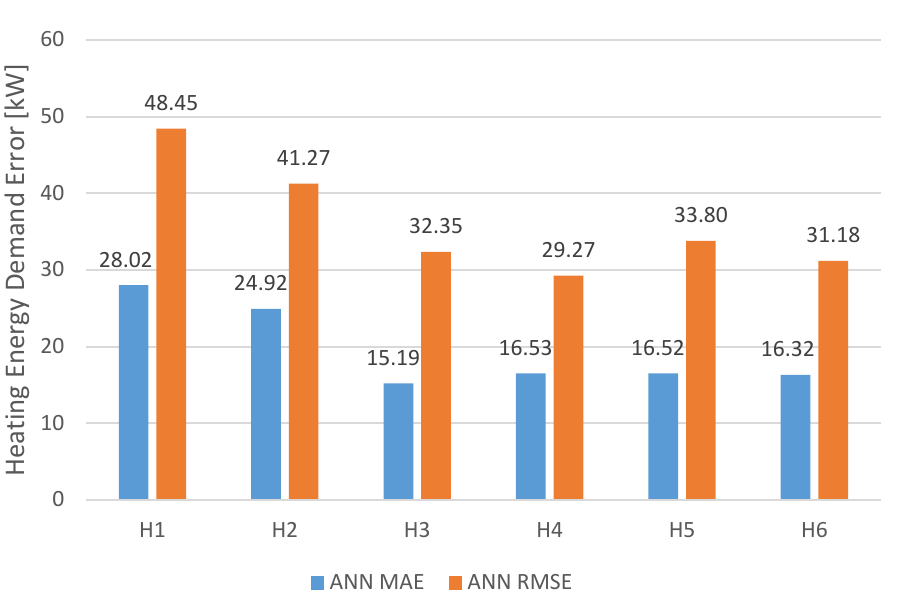
Figure 5. Error metrics for cooling energy demand using artificial neural networks (ANN).